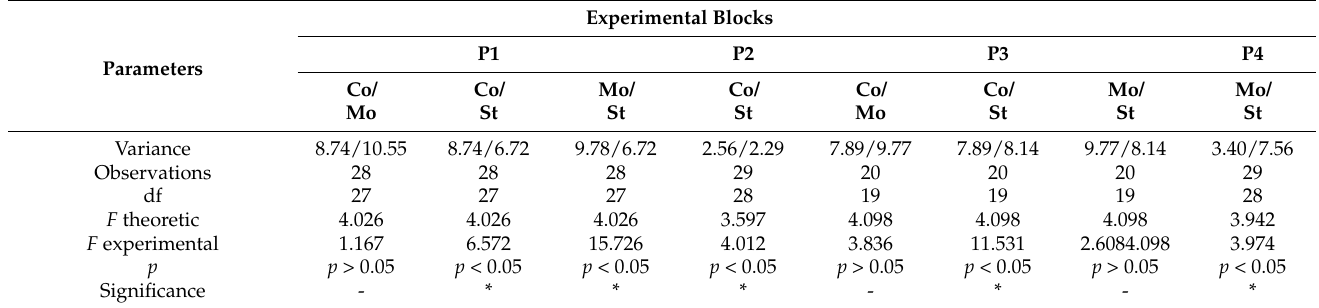
Table 5. Microdrilling result summary of ANOVA tests for significance between the three variants (Co, Mo, St) of the experimental blocks (P1, P2, P3, P4) for microdrilling resistance. Experimental Blocks Parameters